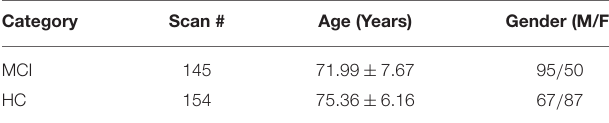
TABLE 1 | The main demographic information of 143 subjects.